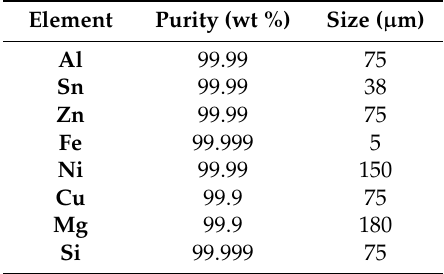
Table 1. Purity and mean particle size of used